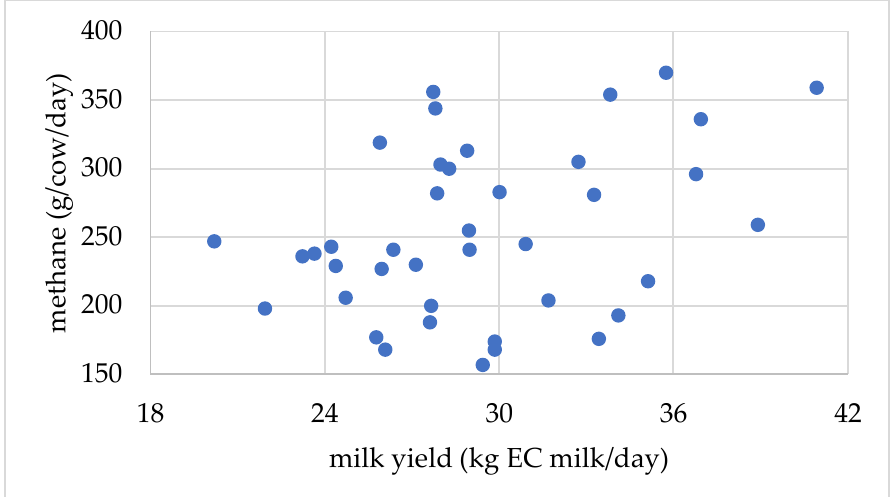
Agriculture 2023 , 13 , x FOR PEER REVIEW Figure 1. Relationship between daily methane output and milk yield . Figure 1. Relationship between daily methane output and milk yield.